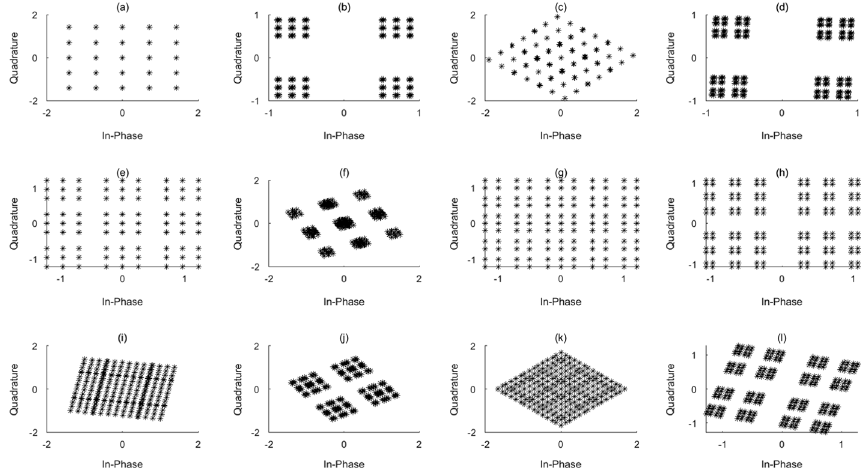
Fig. 5 Special constellation diagrams of